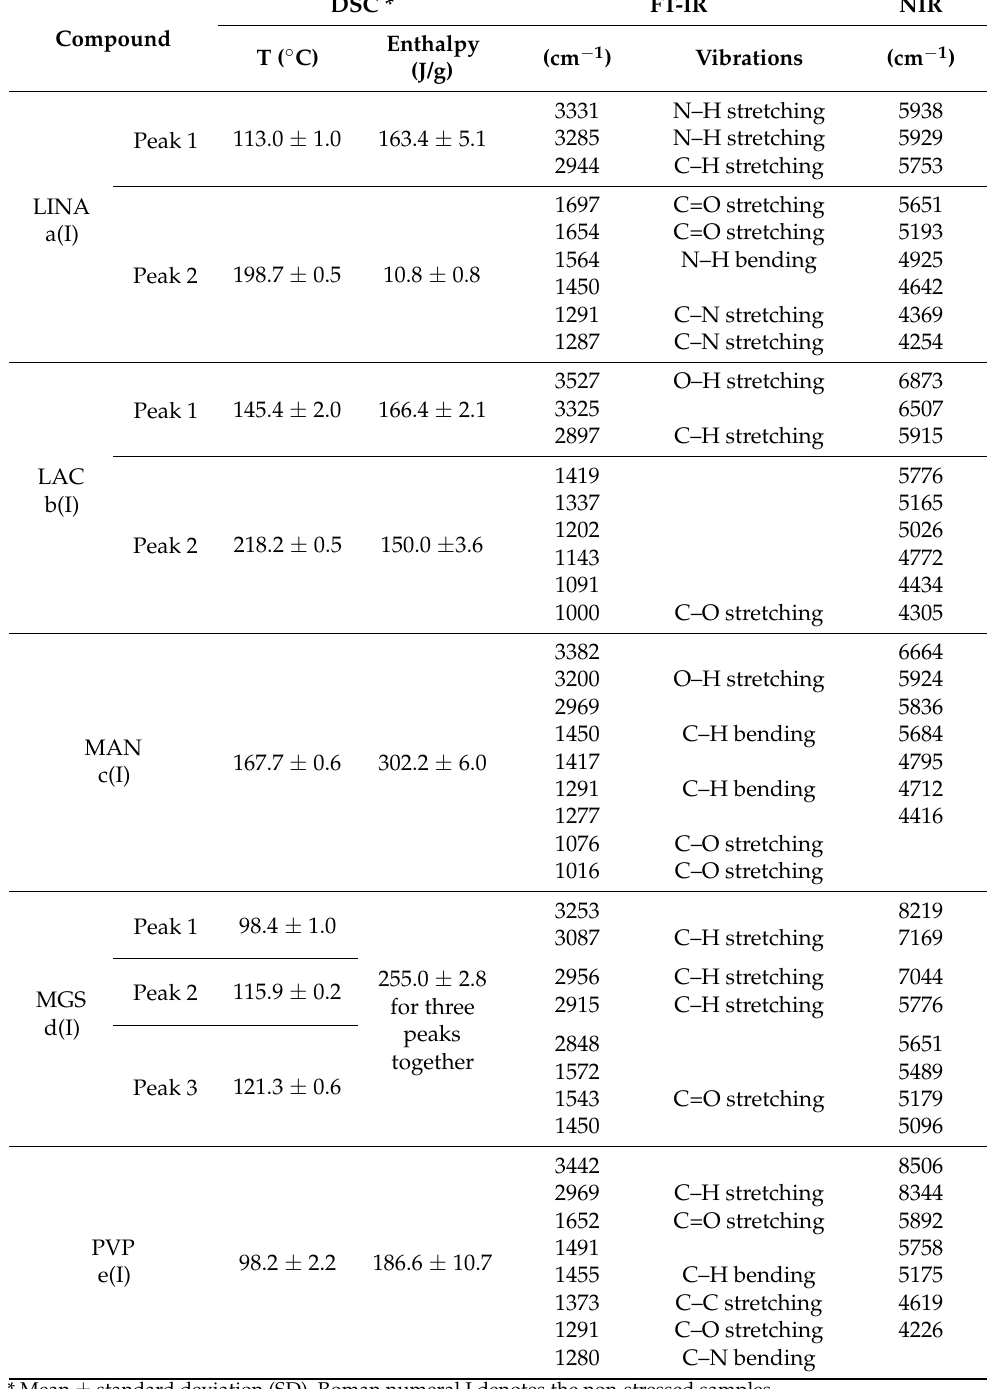
Table 1. DSC, FT-IR and NIR characteristics of pure compounds: linagliptin (LINA), lactose